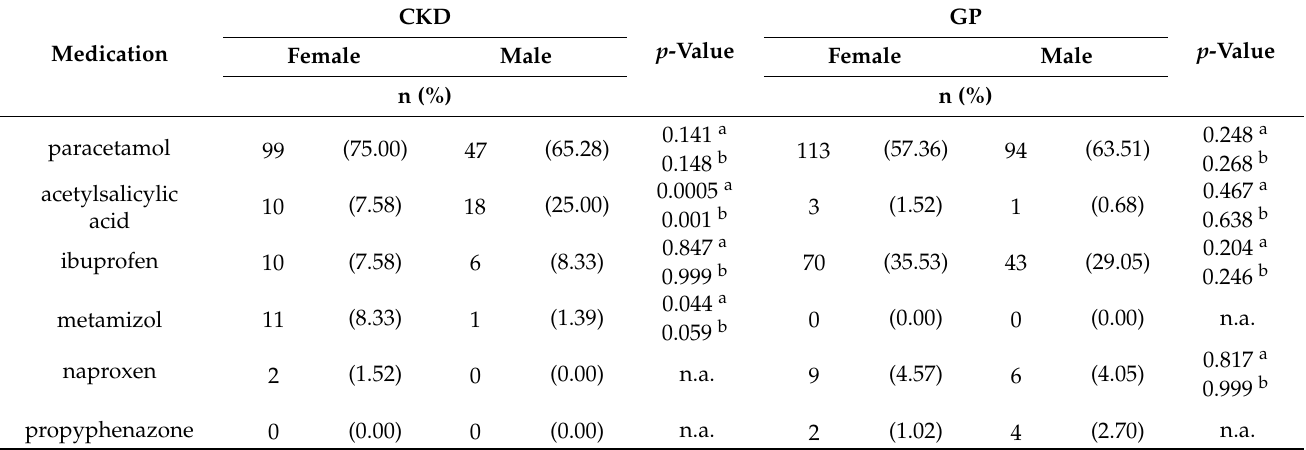
Table 6. The association of gender with type of the most frequently used NSAIDs or analgesics.